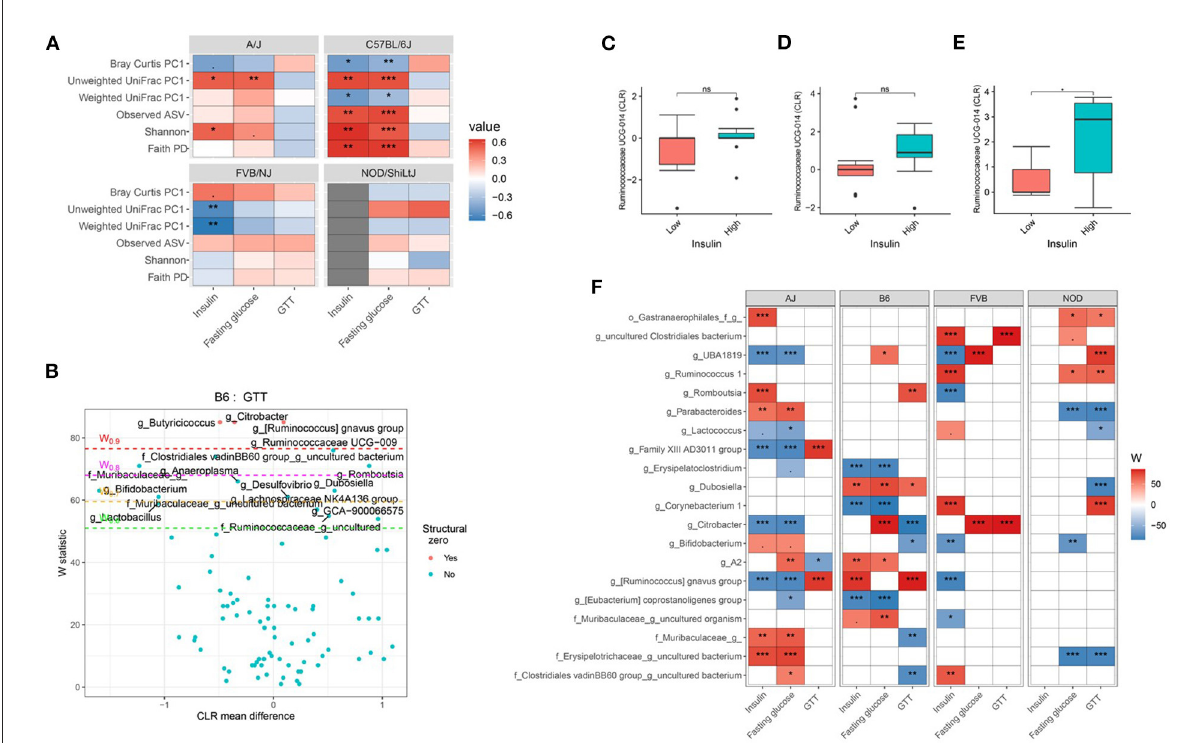
FIGURE6 Host genetics and gut microbiota interact to modulate host glucose metabolism. (A) Association between host glucose metabolism phenotypes and α -diversity or first principal component (PC1) of β -diversity measured by mouse strains determined by using Spearman correlation. As indicated, red represents a positive correlation and blue represents a negative correlation. “***” = adj. p < 0.001, “**” = adj. p < 0.01, “*” = adj. p < 0.05, “.” = adj. p < 0.10. (B) Volcano plot of the differential genera abundance between C57BL/6J mice with high (above median) and low (below median) GTT AUC determined by ANCOM analysis. Structural zero represents the presence of the bacteria in one group and the complete absence in another group. Relative abundance of the Ruminococcaceae UCG-014 in AJ (C) C57BL/6J (D) and FVB/NJ (E) mice with high and low plasma insulin levels. Mean abundance was compared using the Wilcoxon rank-sum test. For (C–E) , “*” = P < 0.05 and “ns” = not significant. (F) Differential genera abundance between high (above median) and low (below median) blood glucose-related phenotypes determined by ANCOM analysis. 20 most differentially abundant (based on cumulative ANCOM W-value) were selected for the graph. For easier presentation, ANCOM W values were converted to negative if CLR effect size is negative. Red indicates higher genera abundance in the above-median group and blue bacteria represents higher genera abundance in the below-median group. White represents a non-significant result obtained from ANCOM analysis. Red and blue represent significant associations determined by ANCOM. Models were adjusted for diet and sex as confounding factors. The median was calculated for each mouse strain. ANCOM models were FDR (BH-method) corrected for multiple comparisons and a significant sub-hypothesis test at a level of adj.P < 0.05 were counted toward W value. For (E) , “***” = ≥ W 0.9 , “**” = ≥ W 0.8 , “*” = ≥ W 0.7 , and “.” = ≥ W 0.6